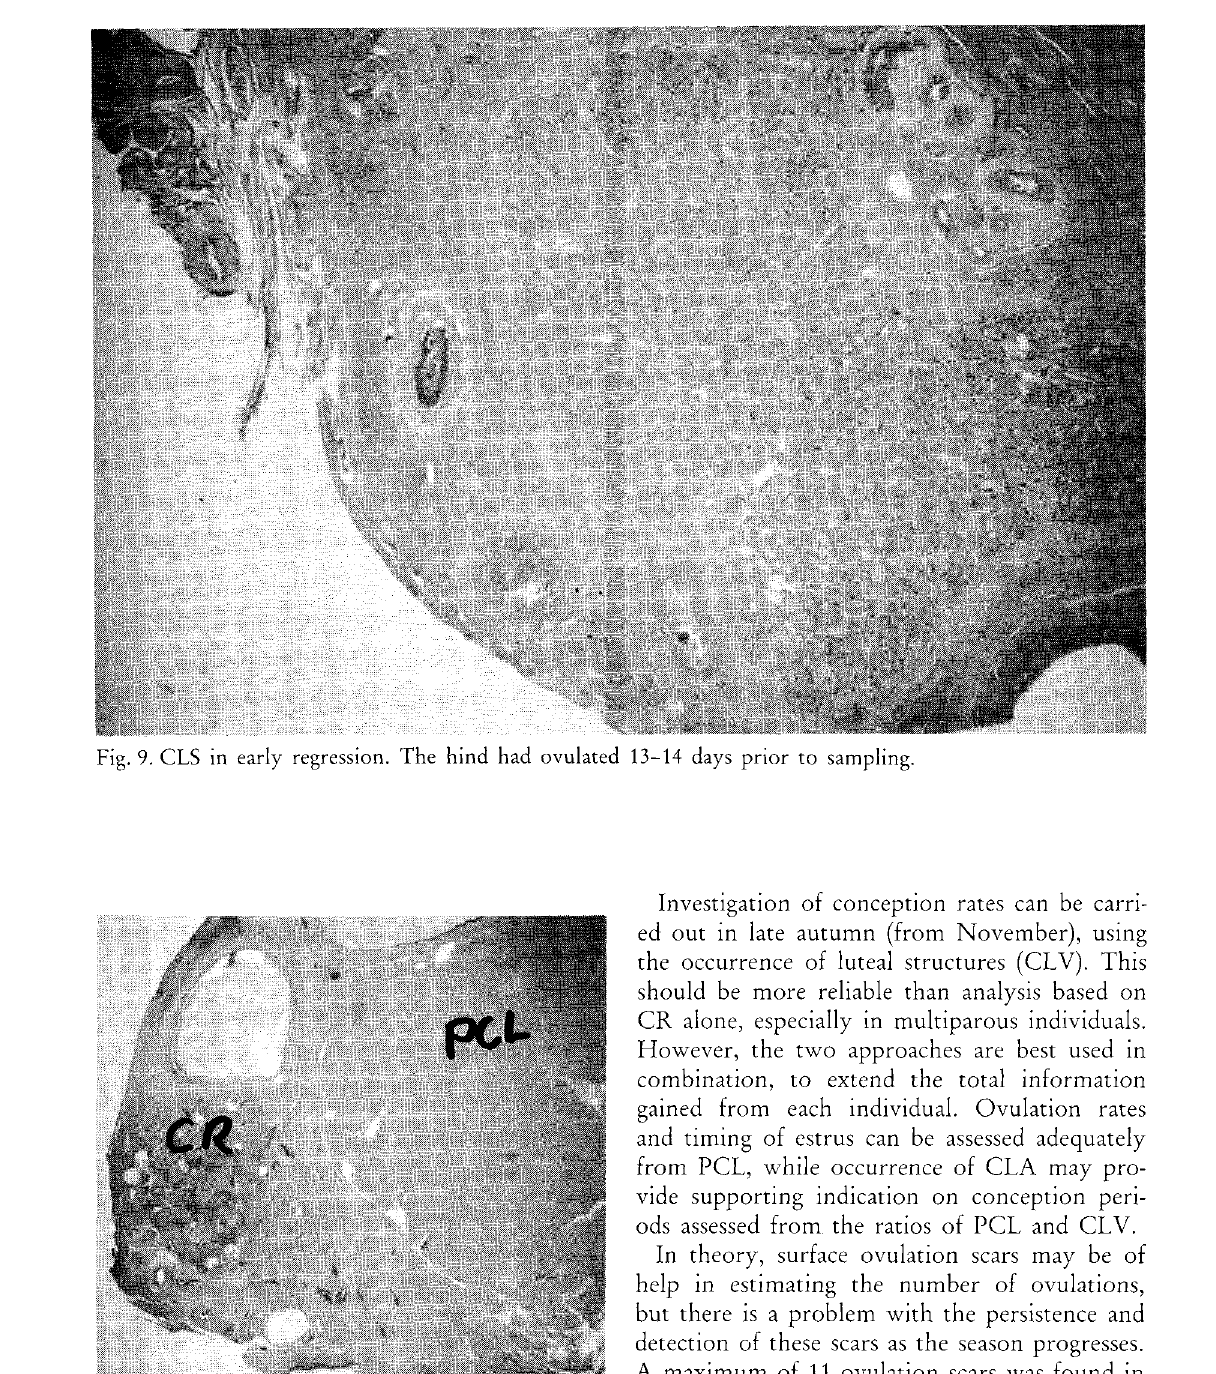
Fig. 10. P CL and CR in ovary from an adult hind sampled October